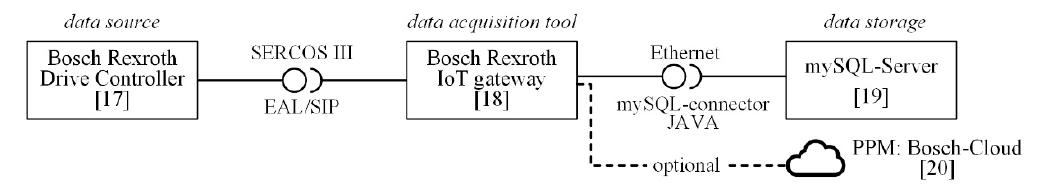
Figure 8. Acquisition concept for the parameters [17–20].